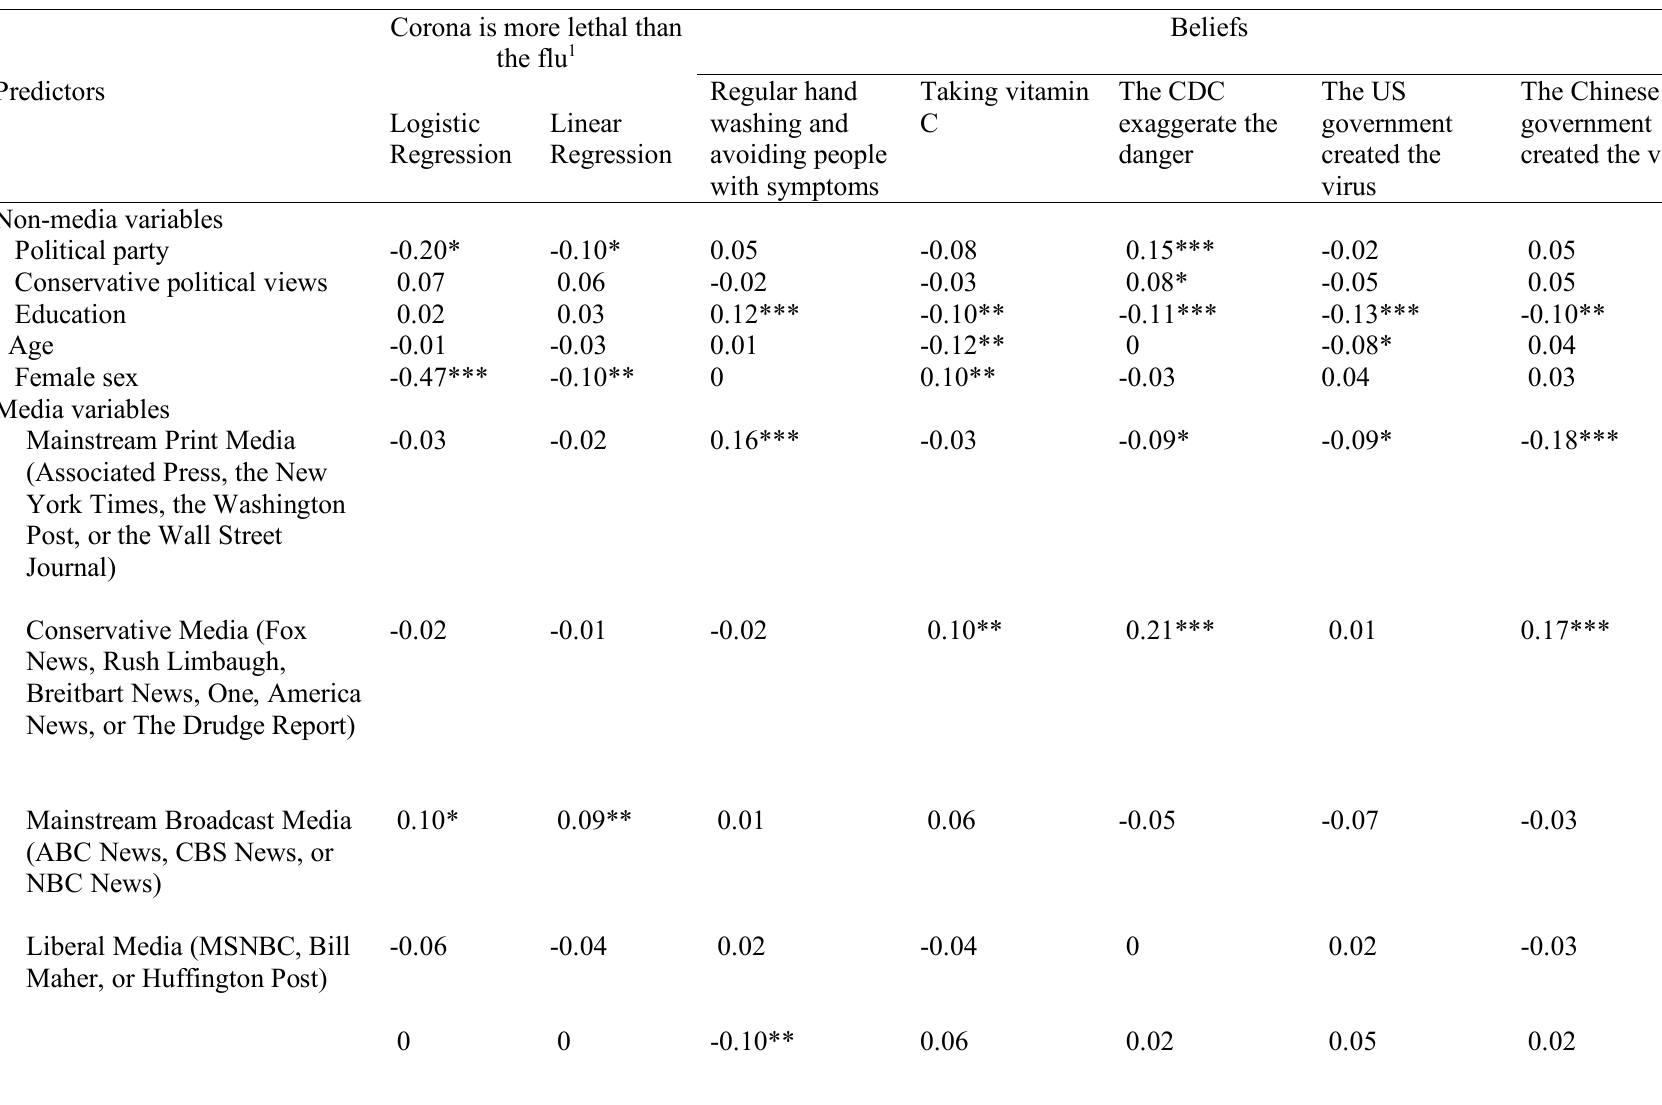
Table 2. Predicting Beliefs from Sources of